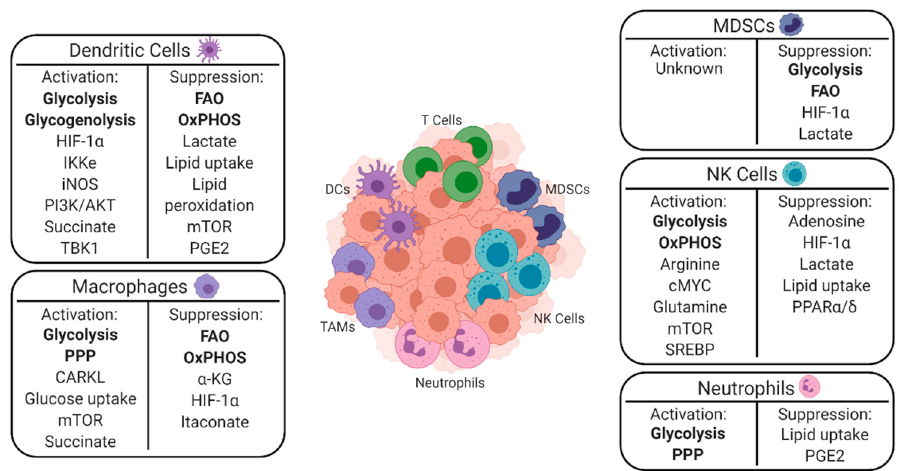
Figure 2. A depiction of innate immune cells within the TME and a summary of the metabolic pathways that lead them to promote either immune activation or suppression. Major metabolic pathways are denoted in bold, with key signaling molecules listed below them. CARKL—carbohydrate kinase-like protein; cMYC-HIF-1 α — hypoxia inducible factor 1-alpha; IKK E —IkB kinase- E ; iNOS— inducible nitric oxide synthase; mTOR—mammalian target of rapamycin; OxPHOS—oxidative